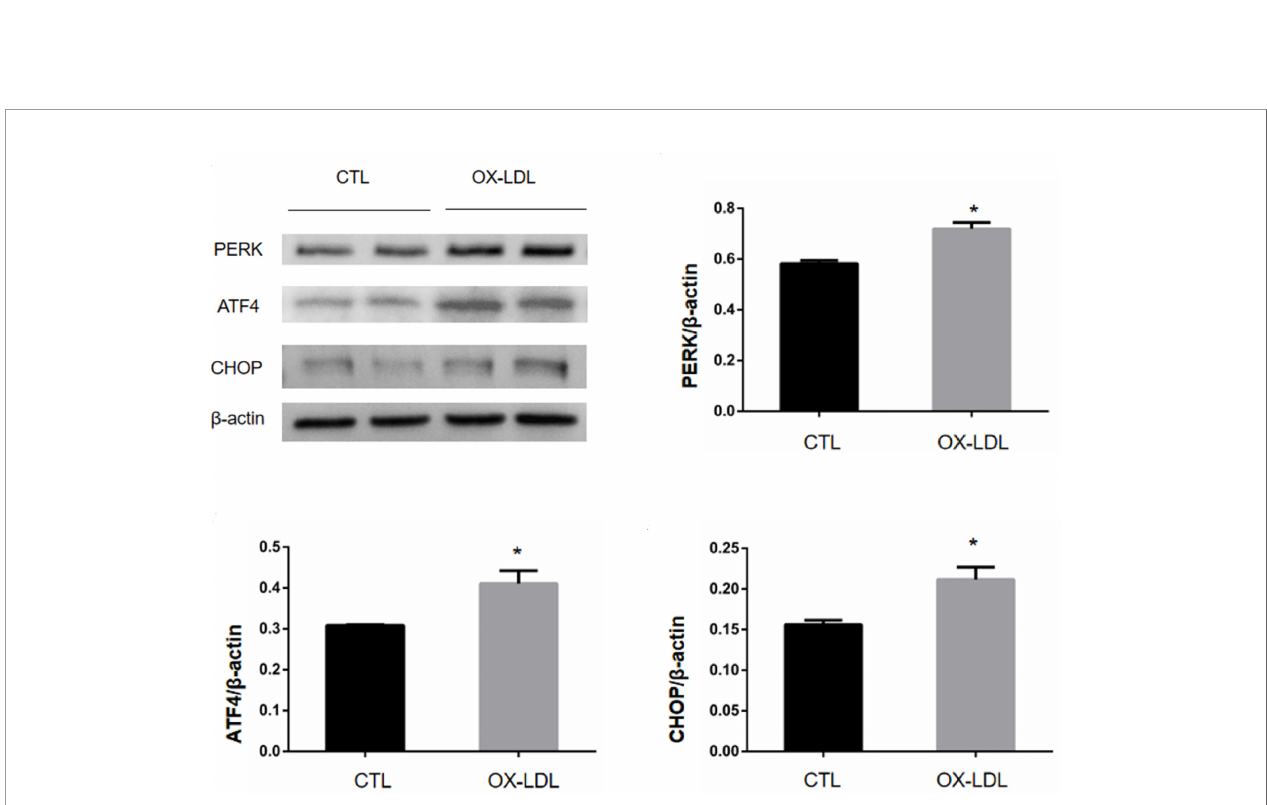
FIGURE 3 | PERK/ATF4/CHOP protein expression of VICs after ox-LDL stimulation. * represents P value less than 0.05, indicating signi fi cant